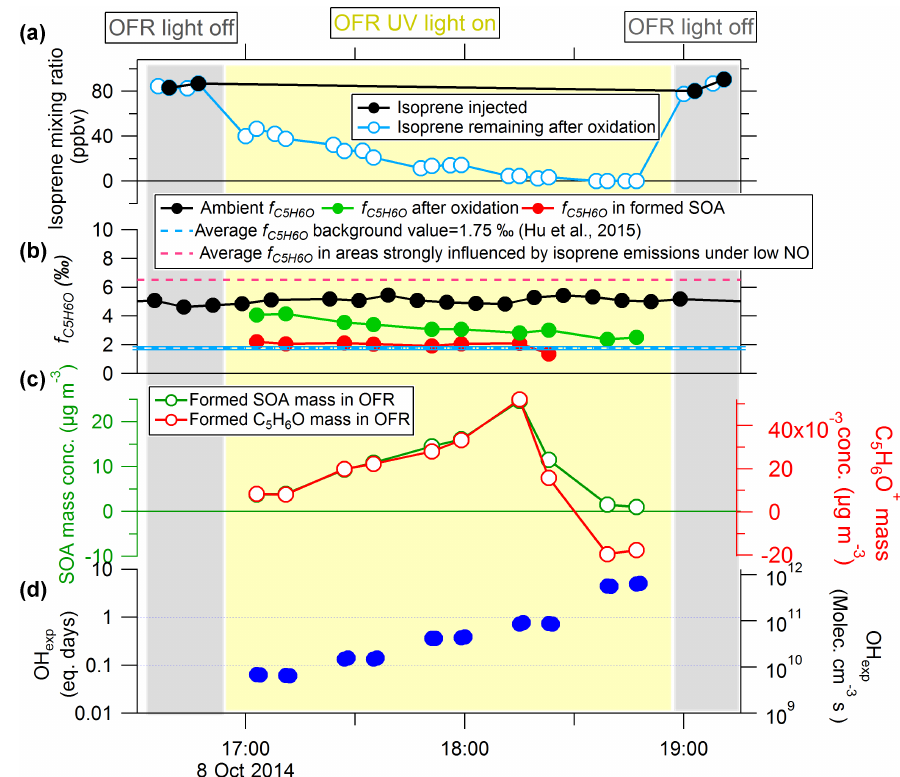
Figure 5. Isoprene standard addition experiment in ambient air during the GoAmazon2014/5 study. (a) Isoprene concentration injected and remaining after OFR. (b) Time series of ambient f C , f C in OA after oxidation and f C in newly formed SOA from 5 H 6 O 5 H 6 O 5 H 6 O = 1.75‰ from urban and biomass burning emissions and f = 6.5‰ from OFR oxidation. The average background value f C C 5 H 6 O 5 H 6 O aerosol strongly influenced by isoprene emissions are also shown (Hu et al., 2015). (c) Time series of mass concentration of newly formed SOA (left axis) and C 5 H 6 O + (right axis). (d) Time series of equivalent aging time (left axis) and OH exposure in OFR (right axis). OH concentration = 1.5 × 10 6 moleccm − 3 was assumed here to calculate equivalent OH aging times. The gray background indicates OFR light off period and light yellow is OFR light on period. Different OH exposures were achieved by varying the UV light intensity. Residence time in the OFR was about